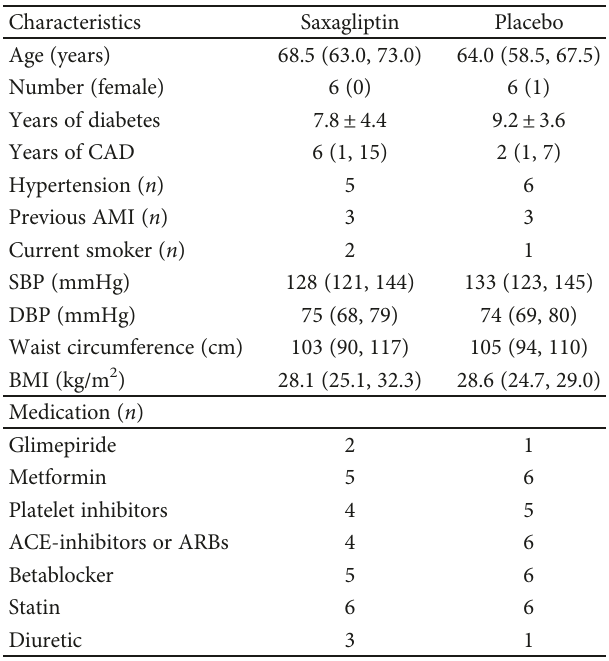
Table 1: Baseline characteristics according to the randomized groups. Median (25, 75 percentiles) or number is